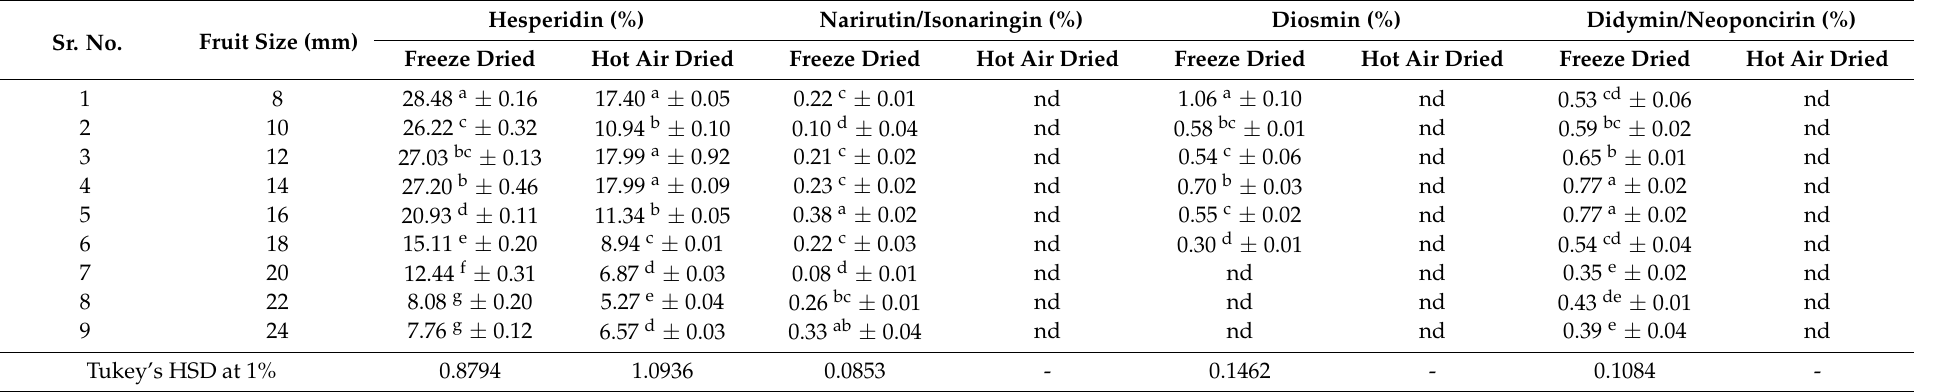
Table 1. Flavonoids content (relative percentage) in Mandarin ( Citrus reticulata Blanco) immature dropped fruits after freeze drying (up to 48 h) and hot air drying (up to 36 h). Sr.